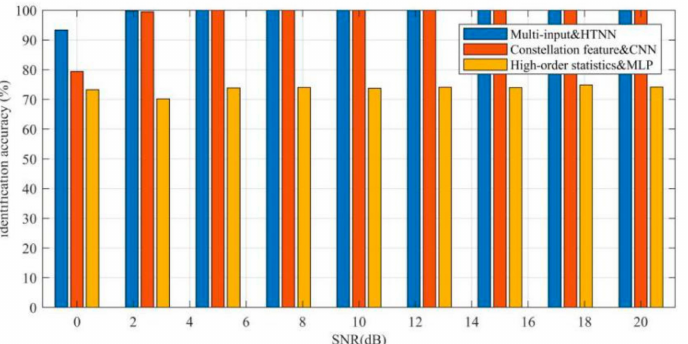
Figure 6. Identification accuracy comparison of different methods against SNR.